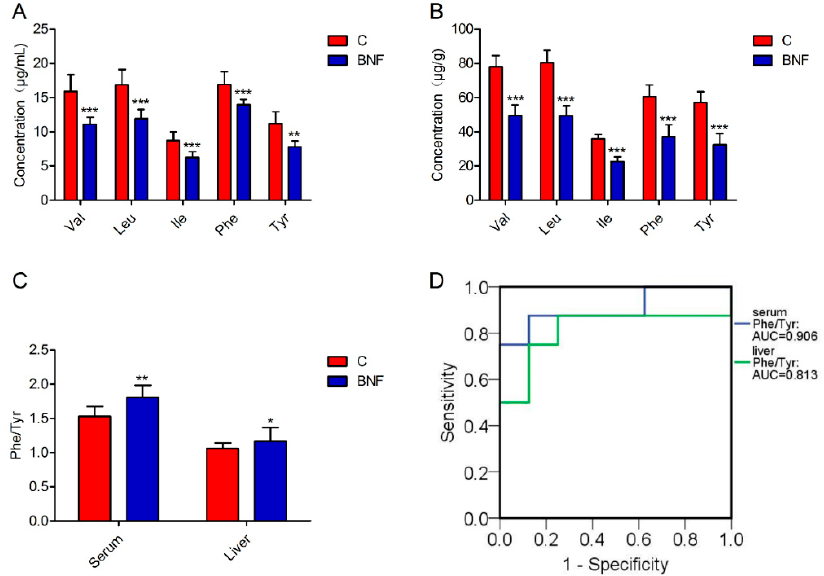
Figure 3. Targeted metabolomic analysis of the focalized biomarkers. ( A ) Concentration of Val, Leu, Ile, Phe, and Tyr in serum. ( B ) Concentration of Val, Leu, Ile, Phe, and Tyr in liver. ( C ) The ratio of Phe to Tyr concentration in the serum and liver. ( D ) ROC curves of Phe / Tyr in serum and liver. Data are presented as mean ± SD, and n = 8 for each group. Nonparametric Mann–Whitney U test. * p < 0.05; ** p < 0.01; *** p < 0.001; C: control group; BNF: β -naphthoflavone treatment group; Val: valine; Leu, leucine: Ile, isoleucine; Phe: phenylalanine; Tyr: tyrosine; and Phe / Tyr, the ratio of Phe to Tyr concentration.